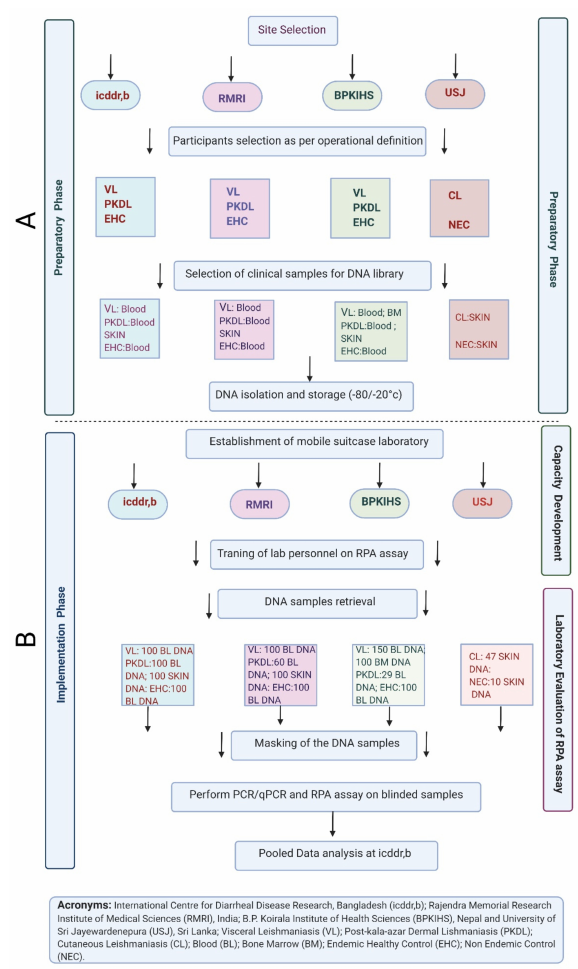
Figure 1. The schematic representation of two phases—( A ) Preparatory Phase and ( B ) Implementa- tion Phase, towards multi-site evaluation of LD RPA assay incorporated in the suitcase